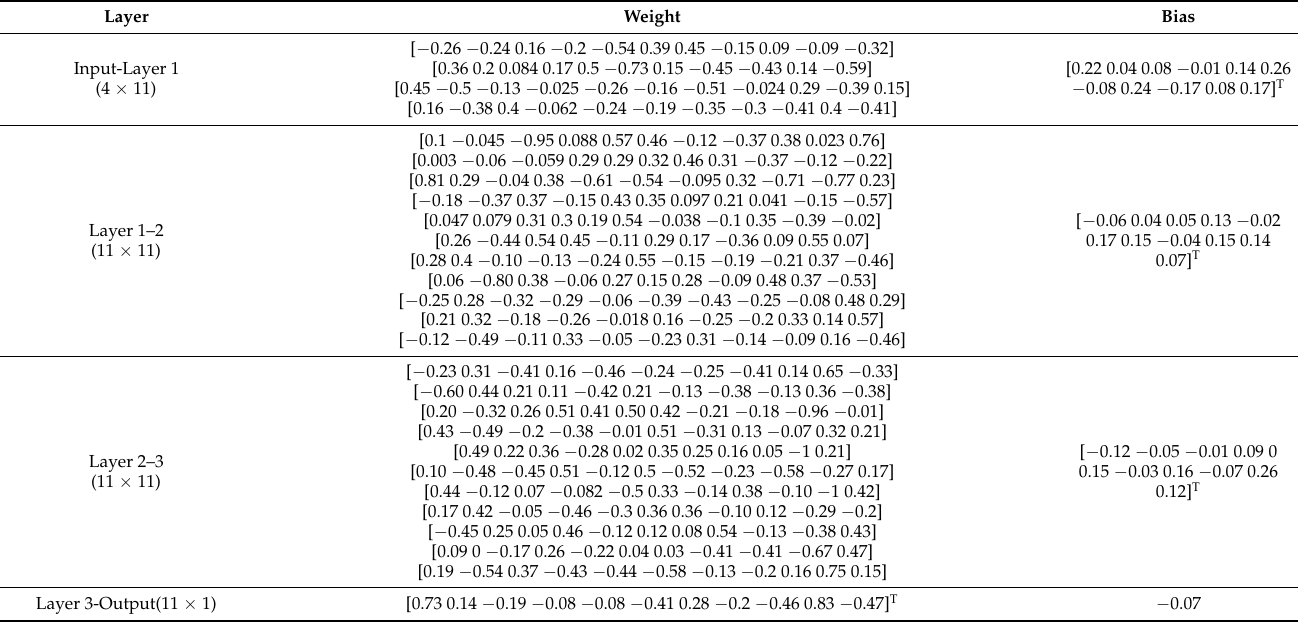
Table A1. The weight and bias results of the optimal